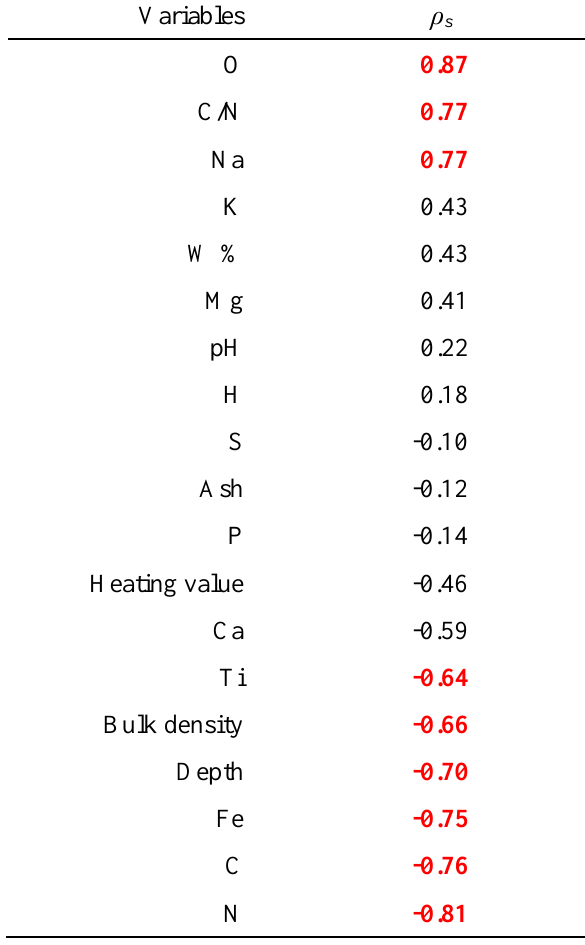
Table 4. Spearman’s rank correlation coefficients (ρ relating mass loss of Sphagnum shoots in litter bags to the measured microhabitat variables (left column). The statistically most significant relationships at the 0.05 level are indicated by bold red